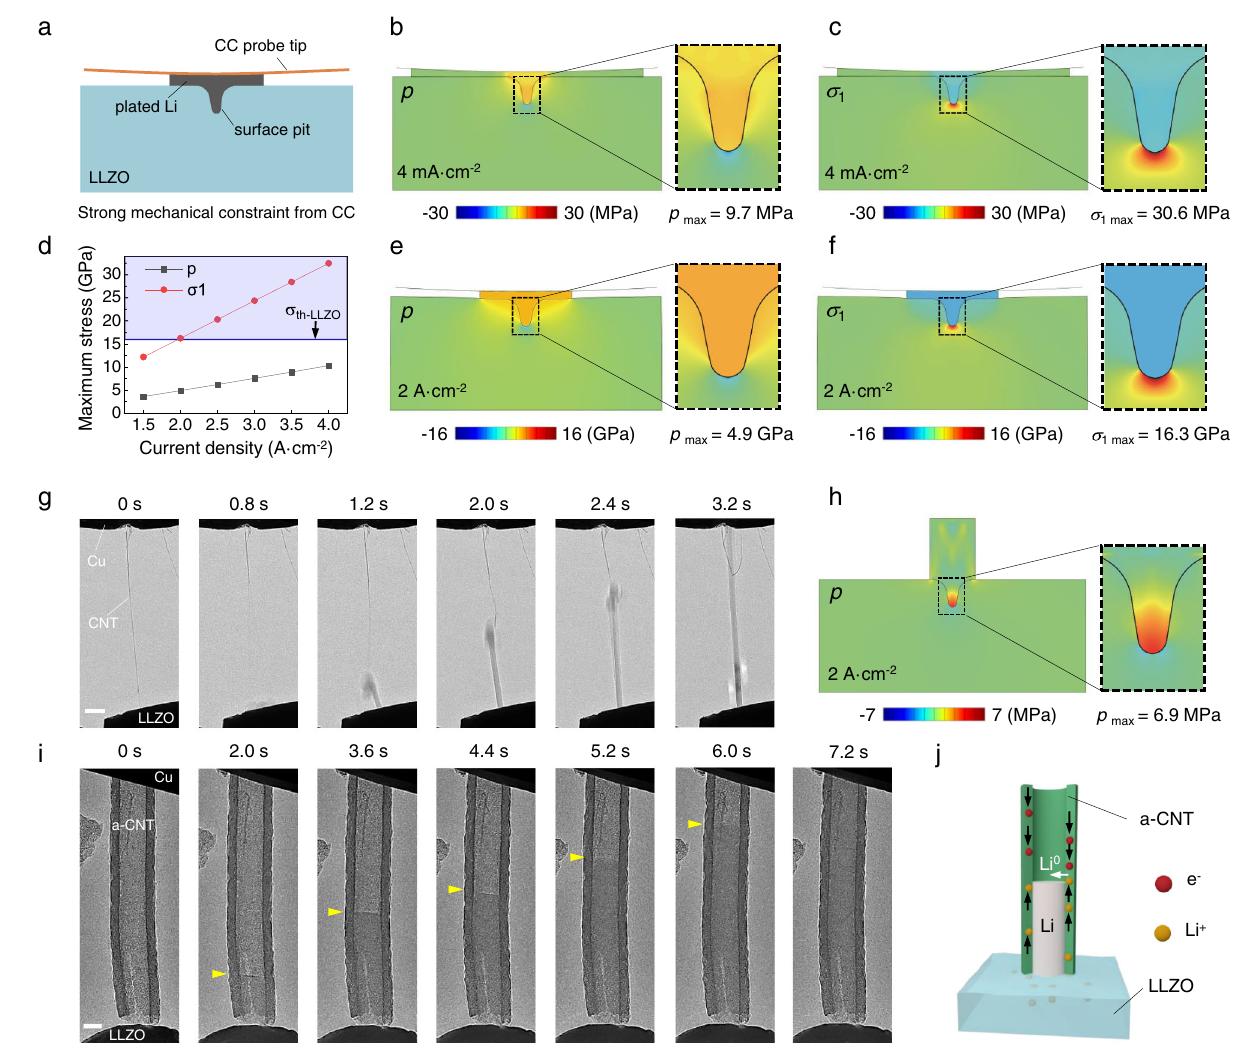
Fig. 4 | Chemo-mechanical simulated stresses in Li and LLZO and demonstra- tions of high-rate damage-free Li deposition. a Schematic illustration of the chemo-mechanical model under strong top mechanical constraint. The pro fi le of the cross section illustrates that the model consists of a LLZO plate with a surface pit, anarc-shapedcurrent collector (CC) probe tip (orange), and a thin layer of the plated Li between them (gray). b – c Distributions of the hydrostatic pressure ( p ) in Li and the maximum principal stress ( σ 1 ) in LLZO at a low deposition rate of 4mAcm − 2 . d The maximum p and σ 1 values as a function of current density under